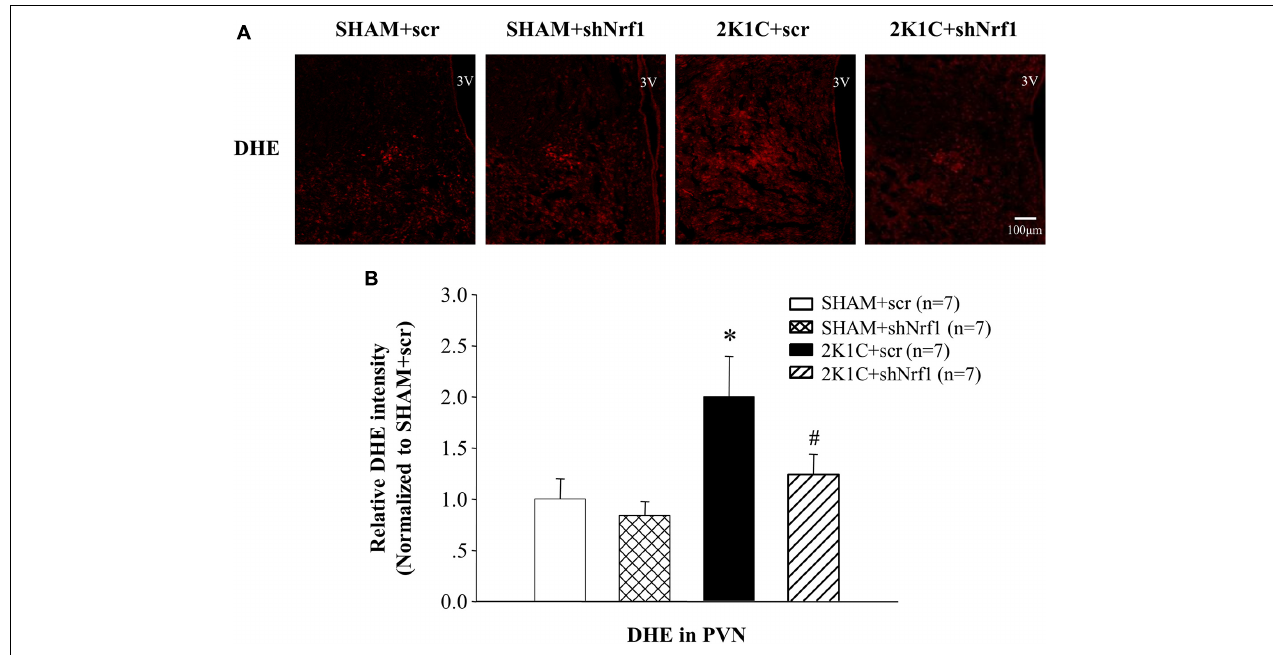
FIGURE 3 | Effects of knocking down of Nrf1 on ROS in PVN of hypertensive rats. (A) DHE staining displaying superoxide anion production in the PVN; (B) Fluorescent intensity of DHE in PVN. ∗ P < 0.05 vs. control animals (SHAM + scr or SHAM + shNrf1). # P < 0.05 2K1C + shNrf1 vs. 2K1C + scr.